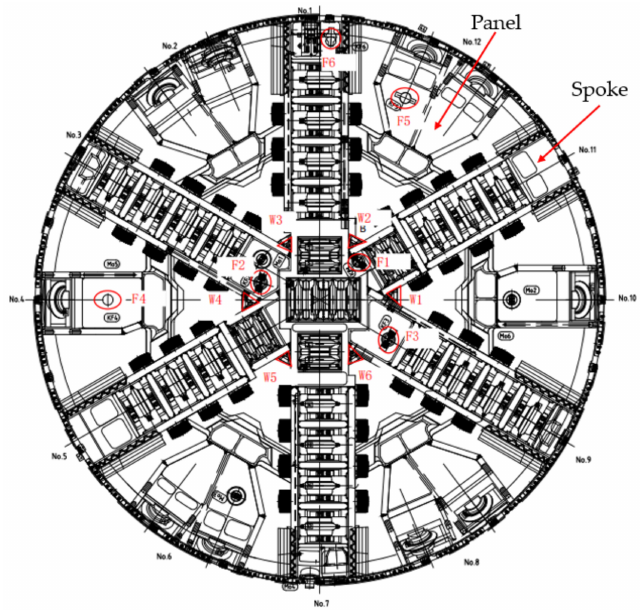
Figure 3. Structure diagram of the cutterhead. F1~F6 were foam injection ports. W1~W6 were high-pressure water injection